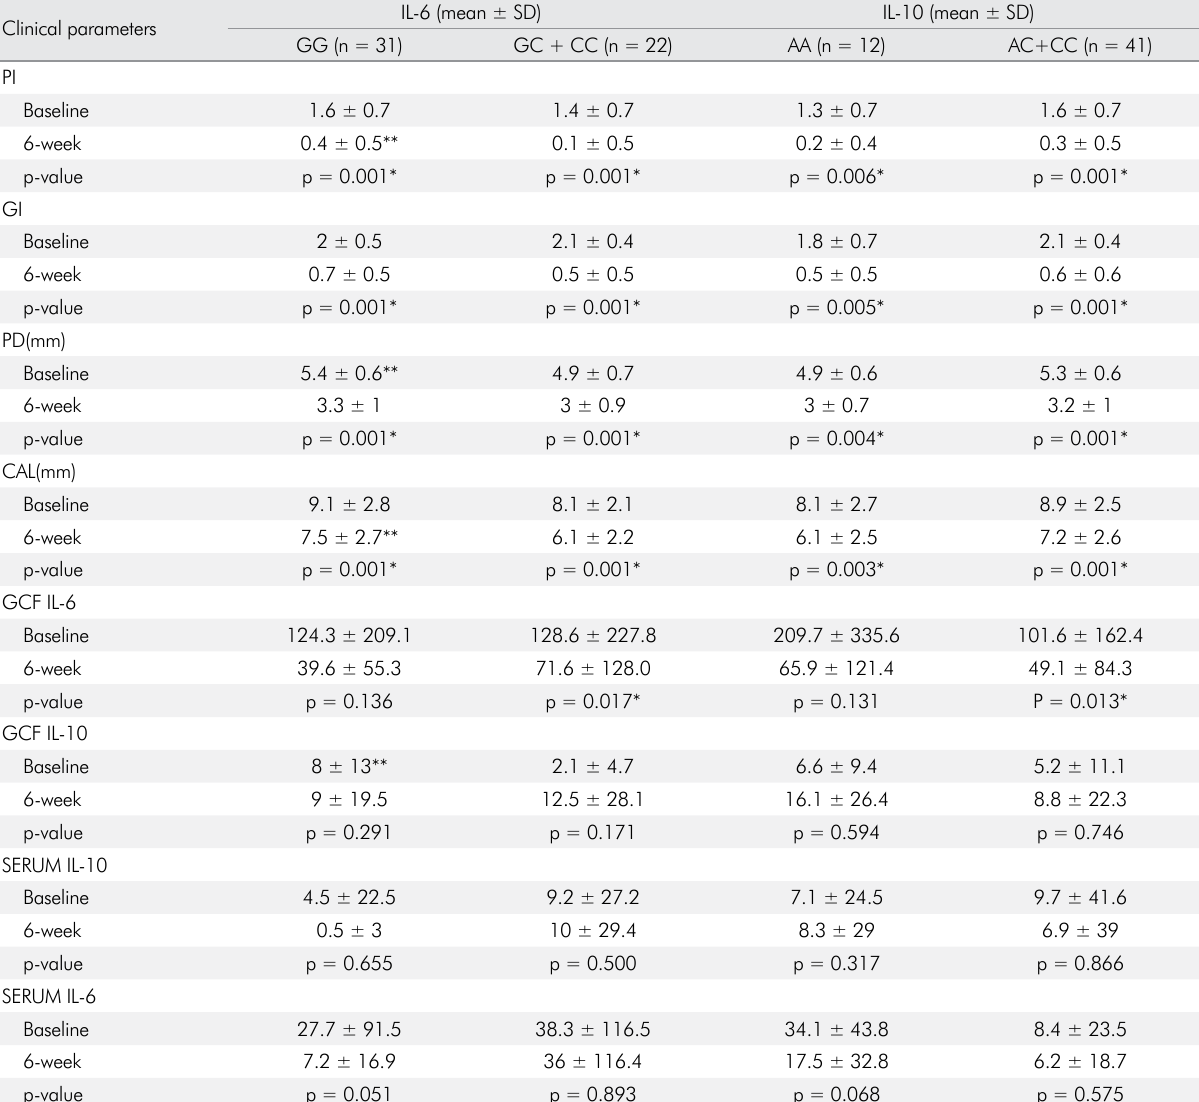
Table 6. Clinical Parameters, GCF and serum cytokine levels in generalized aggressive periodontitis group distributed by IL-6 and IL-10